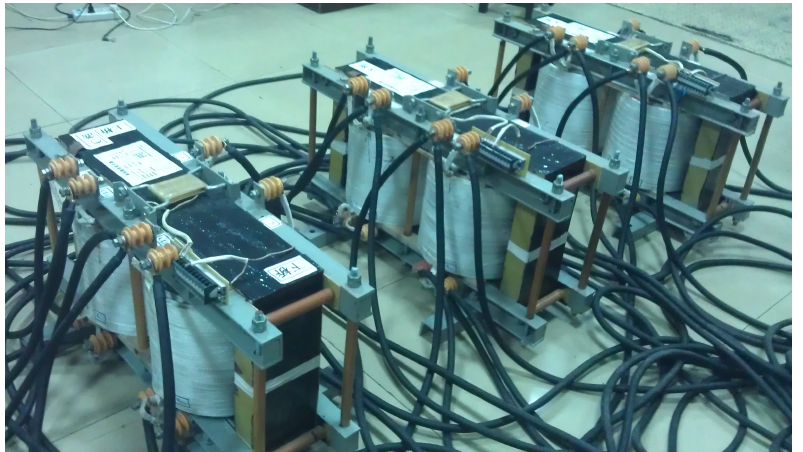
Figure 3. Structural model of single-phase